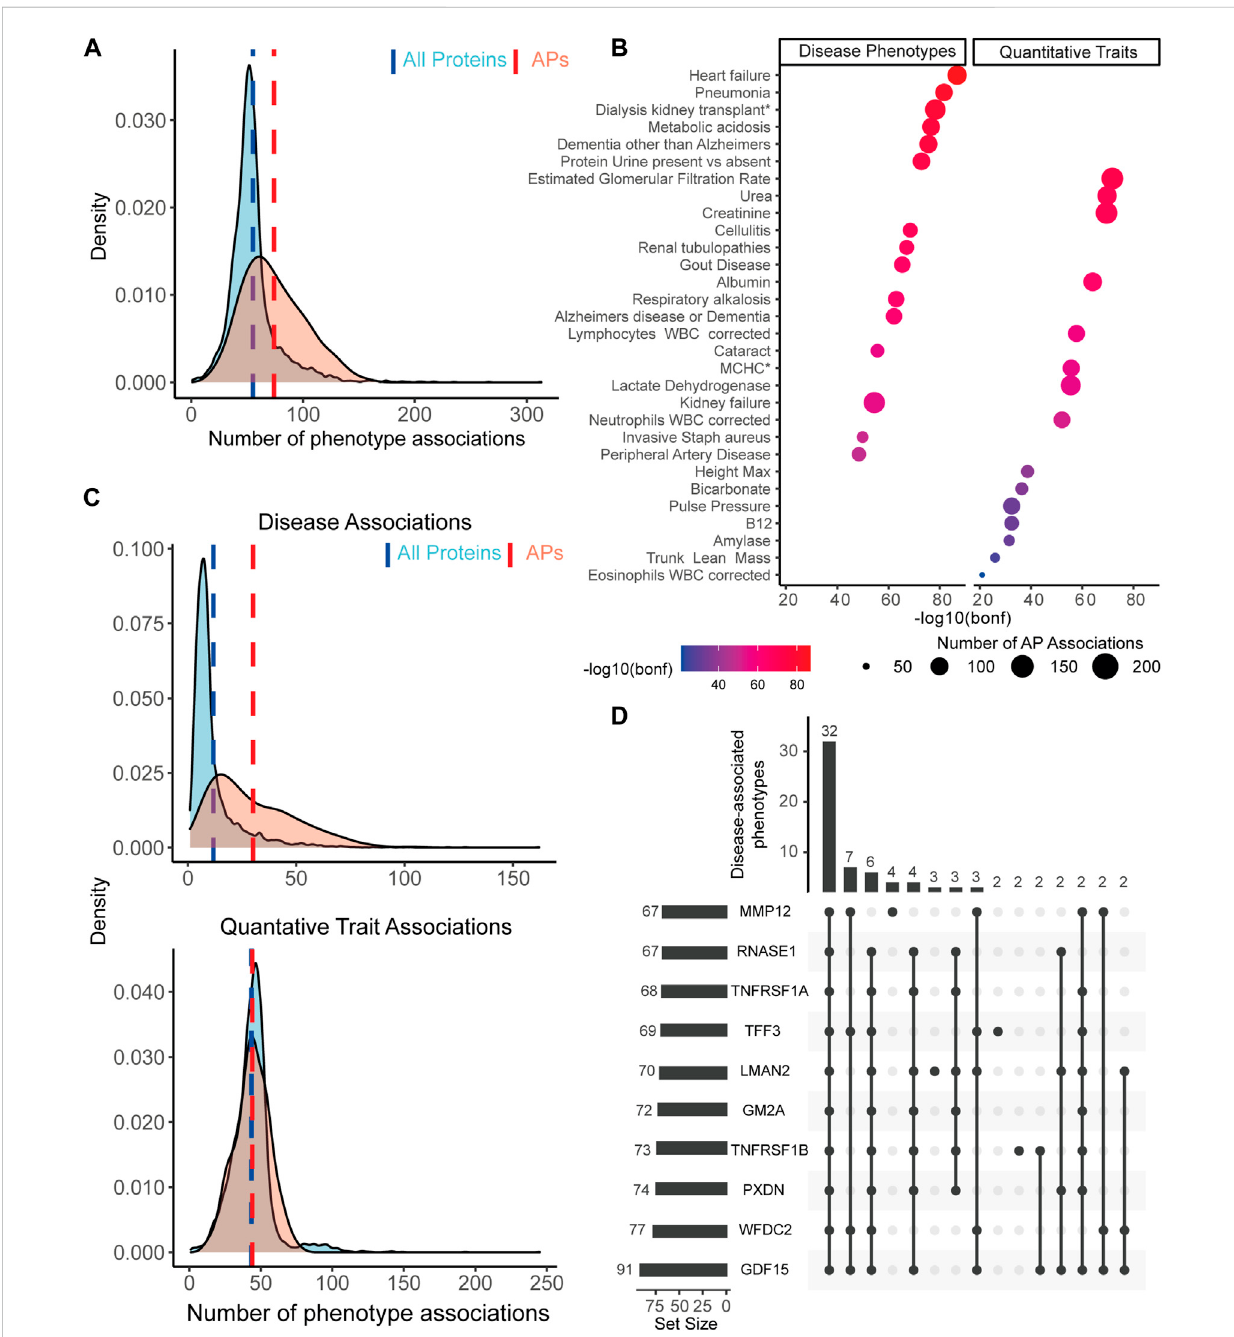
FIGURE 3 APs are more associated to disease-associated phenotypes than the rest of the plasma proteome. (A) APs (red distribution) show on average (red dashed line) signi fi cantly more associations across all included phenotypes than all other measured plasma proteins (blue distribution and dashed line). (B) Overview of the top 15 most AP enriched disease phenotypes and quantitative traits across 179 enriched phenotypes, ranked by Bonferroni corrected signi fi cance levels. Dot color represents the signi fi cance level on a log10(Bonferroni-adjusted p -value) scale. Dot size representsthenumber of APsassociatedto the corresponding phenotype. (C) Whendividing allphenotypesbased ondiseasephenotypes or QTs, we observe on average a signi fi cantly higher number of associations between APs and diseases compared to the rest of the plasma proteome (top distributions), but not between APs and QTs (bottom distributions). (D) Upset plot with an overview of the top 10 proteins associated with the most diseases, as re fl ected by the set size in the bar graph on the left side. Bar graph on top re fl ects the number of shared diseases across a subset of proteins, as illustrated by the dark dots represented below each graph. Numbers on top represent the number of shared phenotypes for the given subset of